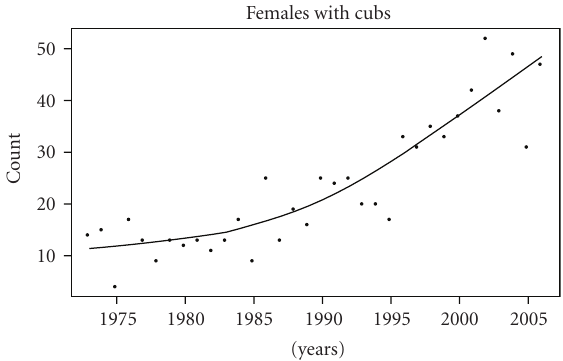
Figure 1: Plot of “unduplicated” data with lowess smoothed